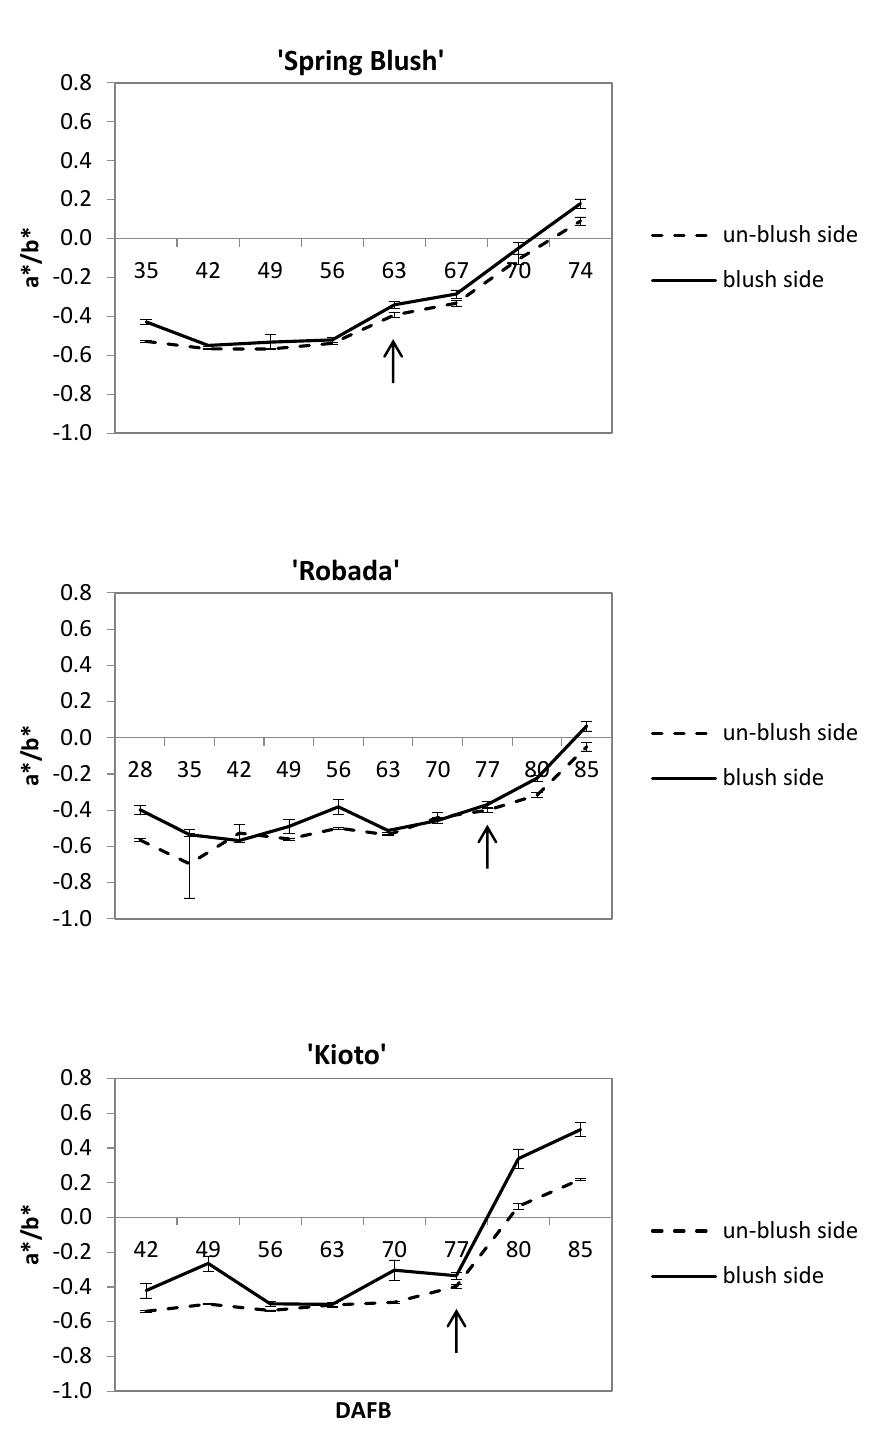
Figure 3. Evolution of the a*/b* skin colour index of apricot cultivars from full bloom to maturity on the tree. The arrow indicates the time of the initial change in fruit colour. Mean values ± standard error (n =